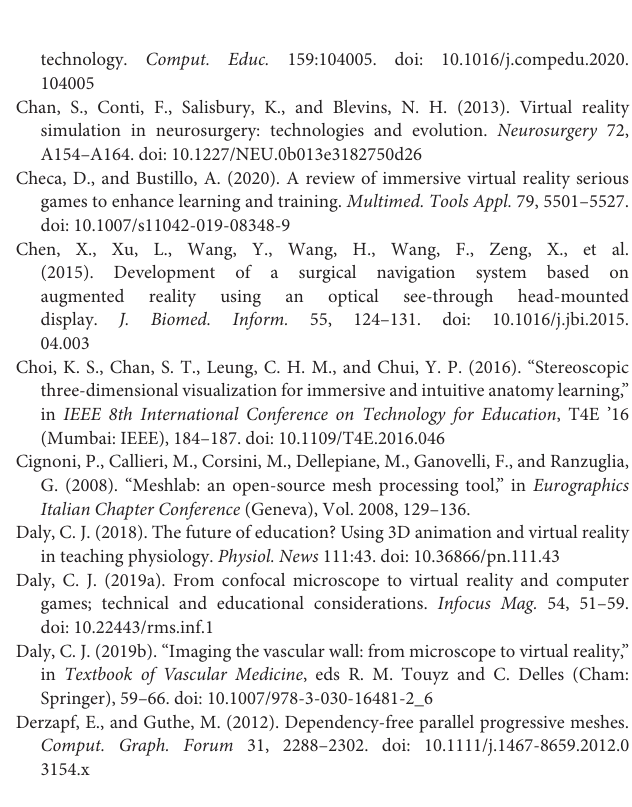
Supplementary Figure 1 | Showcasing our non-VR volume renderer. Endothelia of blood vessels are stained brown in “bone marrow” data set. The blended-in mesh is blue. The volume renderer played an important role in data verification for our publication (Steiniger et al., 2016). (A) Shows volume data representation, (B) presents the visualization of the final, filtered mesh vs. corresponding single